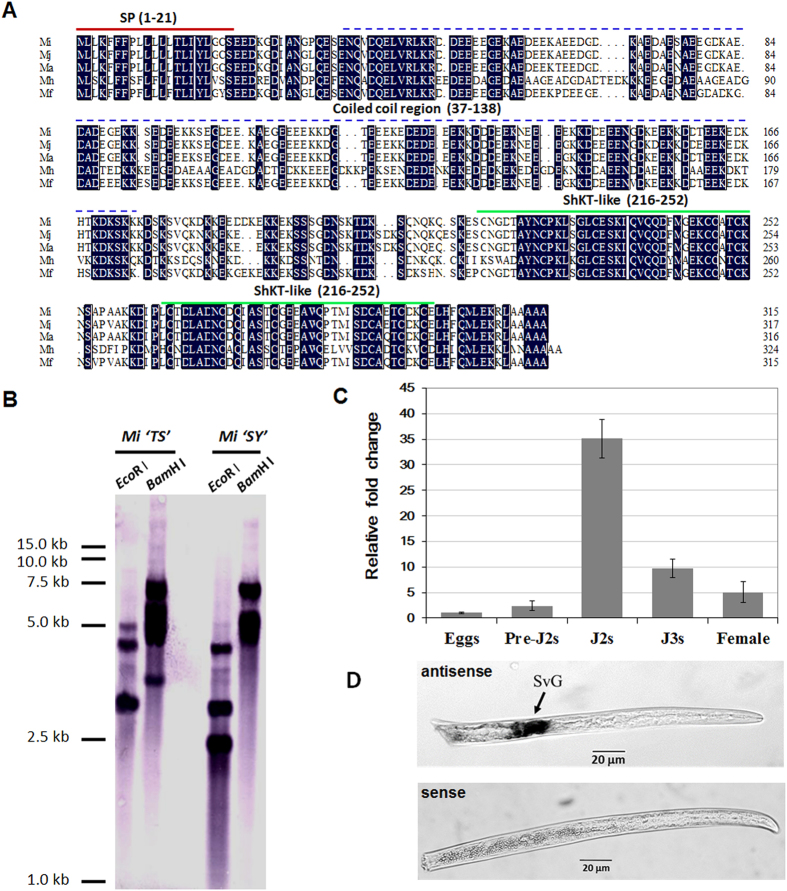
Characterization of M. incognita Msp40.(A) Multiple sequence alignment of the predicted Meloidogyne Msp40-like protein sequences. Absolute conserved residues are shaded dark. The underlined sequences indicate predicted signal peptides (1–21 aa), the coiled-coil region (37–174 aa) and two ShKT motifs (216–252 aa, 264–300 aa). (B) Southern blotting to determine the genomic copy number of MiMsp40 for M. incognita strains ‘TS’ and ’SY’ revealed that MiMsp40 belongs to a small gene family composed of at least three members. (C) Developmental expression pattern of MiMsp40. The relative mRNA expression level of MiMsp40 was quantified by qPCR in five different M. incognita life stages: eggs, pre-J2s, par-J2s, J3s and females. (D) In situ localization of MiMsp40 mRNA. Digoxigenin-labelled antisense MiMsp40 cDNA probe (dark staining) to transcripts specifically expressed within the subventral pharyngeal glands (SVG) of a parasitic juvenile. scale bar = 20 μm.